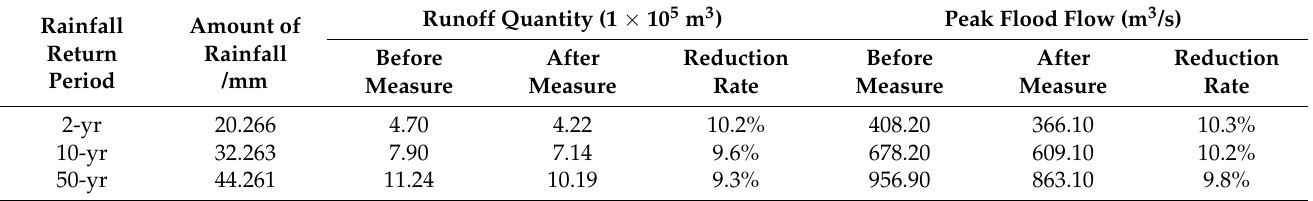
Table 6. Surface runoff analysis under different return